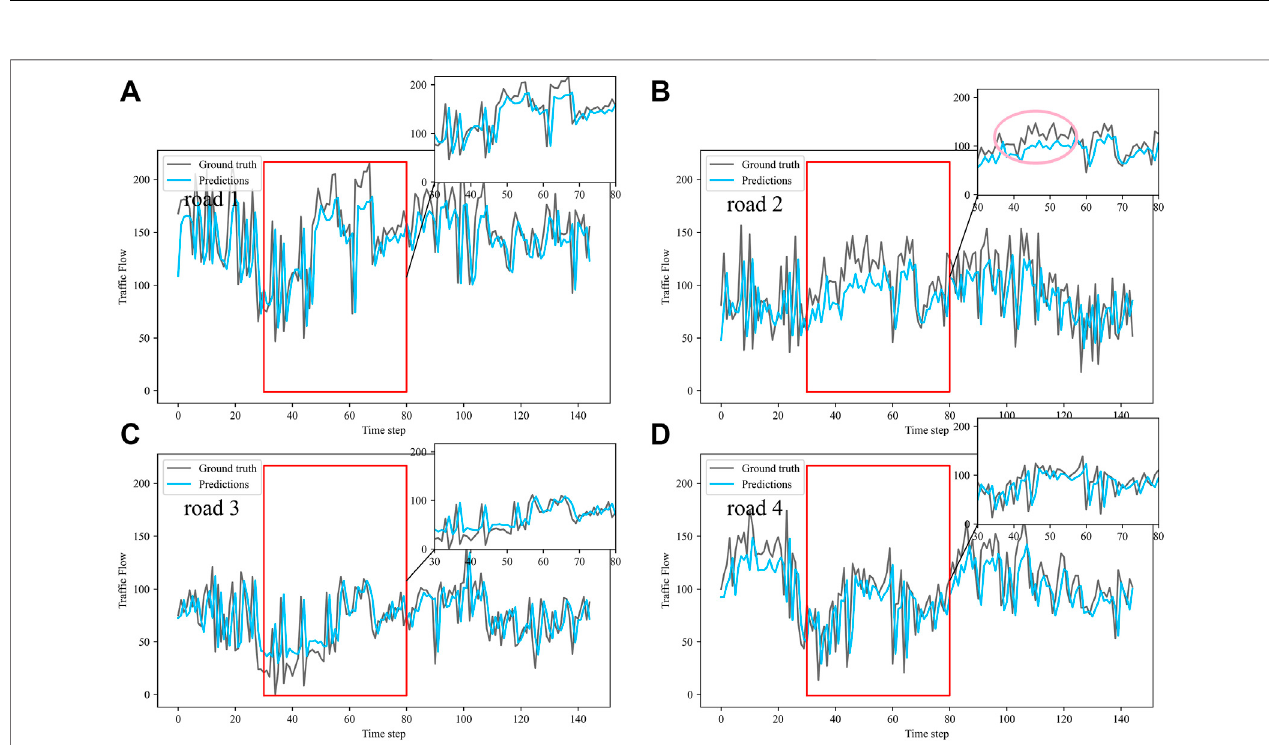
FIGURE 11 | Visualization of IMgru model prediction results on peak dataset. (A) road 1 means Gudun Road. (B) road 2 means Fengtan Road. (C) road 3 means Yile Road. (D) road 4 means Jingzhou Road.